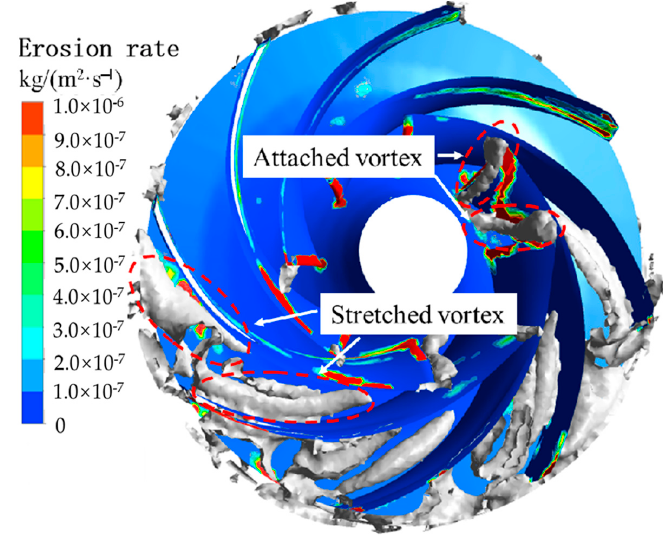
Figure 14. Vortex structure in double-suction centrifugal pump.